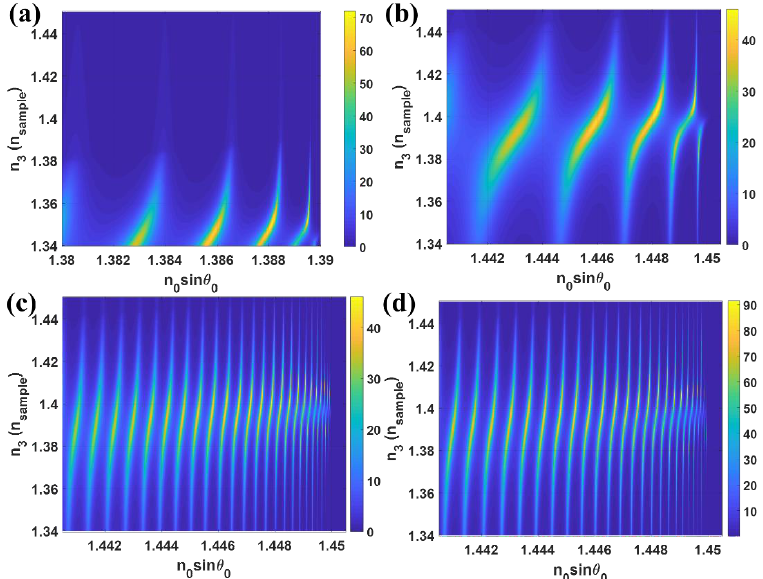
Figure 11. t p | 2 responses when the sample refractive index n 3 changed from 1.34 to 1.45. ( a ) n 0 =